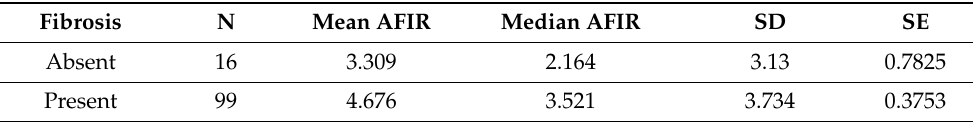
Figure 4. Autofluorescence Intensity Ratio in a group of NMSC (BCC and SCC). No statistically significant differences between the mean of AFIR in BCC and SCC groups were detected (Student’s t p = 0.170; Mann–Whitney U p = 0.143). AFIR of BCC and SCC histological subtypes as well as the lowest and highest values recorded are summarized in Tables 1 and 2. Table 1. Mean AFIR among different BCC subtypes. Table 3. Descriptive statistics for the variable “Fibrosis”. AFIR: autofluorescence intensity ratio; SD: standard deviation; SE: standard error.